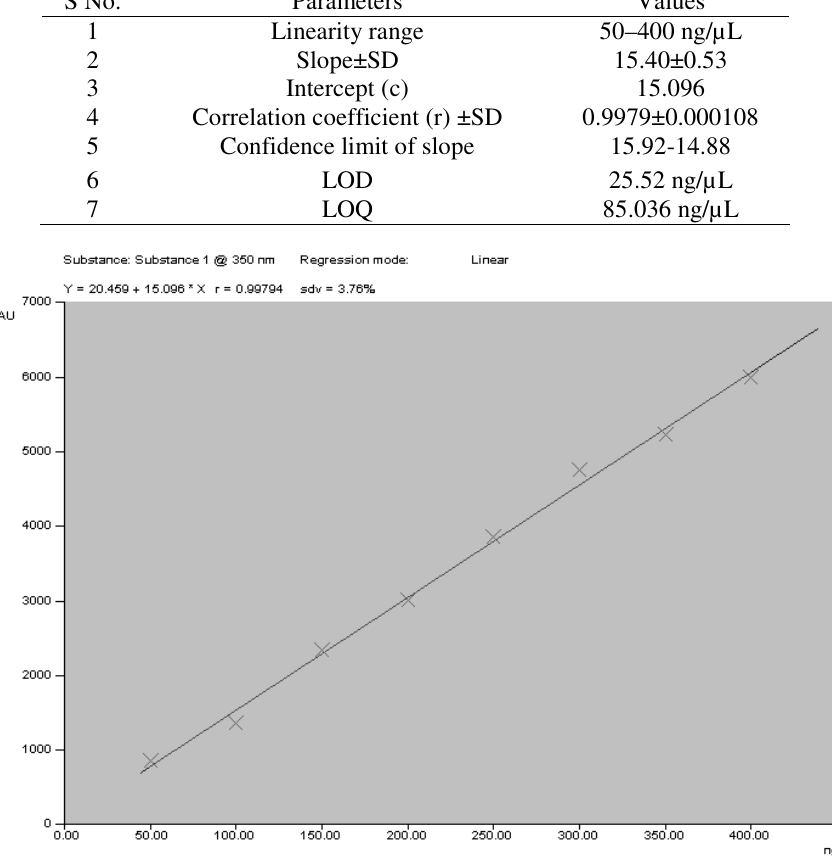
Table 1. Calibration curve of standard rutin trihydrate is presented in Figure 1. Table 1. Linear regression data for the calibration curve (n=6) S No.